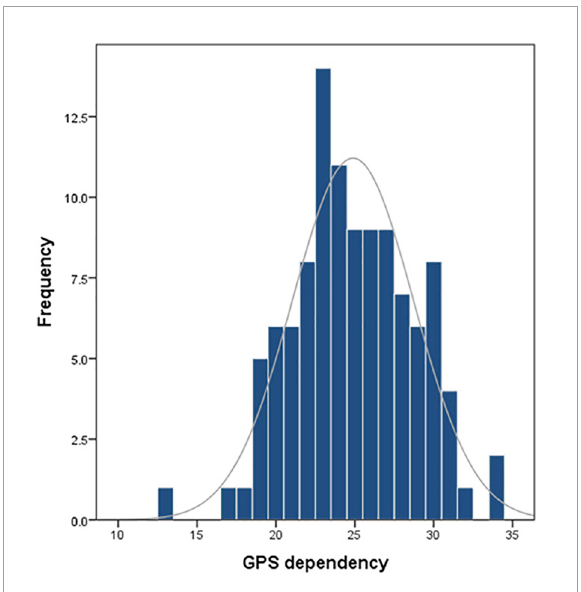
FIGURE2 Distribution of GPS dependency score in the cohort.